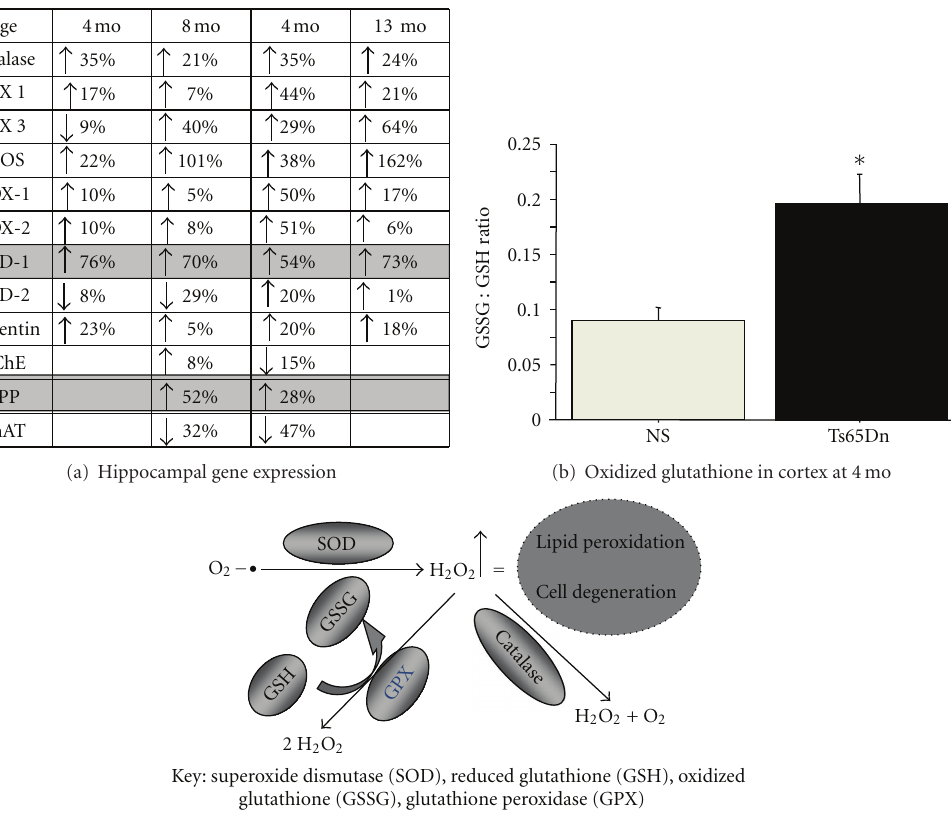
Figure 4: (a) Superarray (SABiosciences, Frederick, MD) against oxidative stress and inflammatory markers was used on hippocampal tissue from pooled samples (3 per group) of Ts65Dn and Normosomic mice at 4, 8, 10, and 13 months of age. Note the increased expression in APP and SOD-1 due to increased gene dosage of these genes. However, glutathione peroxidase 1 and 3 (GPX 1 and 3), as well as catalase levels, were not increased to the same extent. Further investigation of the glutathione enzymatic pathway revealed increased GSSG:GSH ratio in Ts65Dn compared to normosomic brain (b), suggesting, a compensatory processing of free radicals, but not su ffi cient to eliminate peroxidation in neurons. Glutathione exists in two forms: GSH (reduced form) and GSSG (oxidized form). Normally the relationship between these two forms is 1:10 in healthy cells. (c) Schematic representation of the ROS scavengers, demonstrating that elevated SOD levels may lead to increased H 2 O 2 levels, leading to enhanced stress on the glutathione and catalase pathways. Data were not published